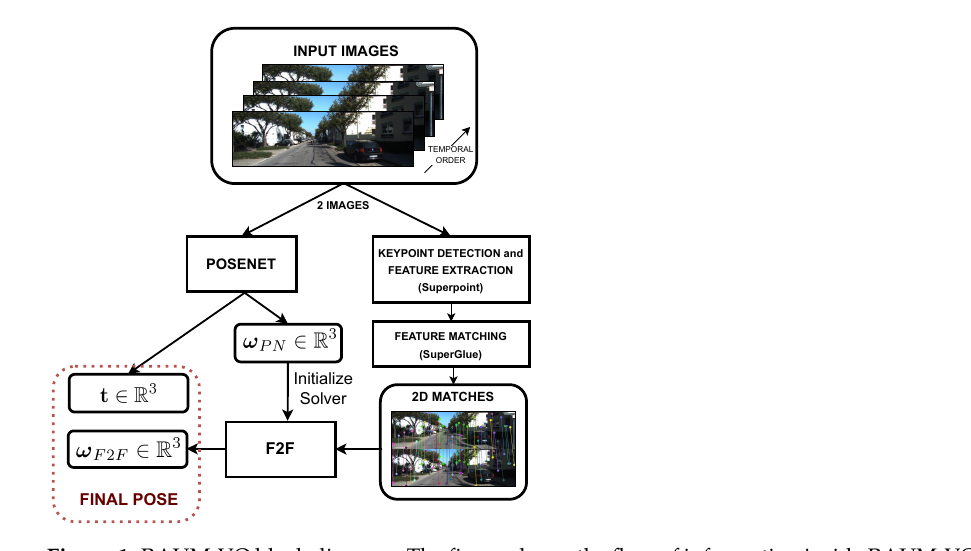
Figure 1. RAUM-VO block diagram. The figure shows the flow of information inside RAUM-VO from the input image sequence to the final estimated pose between each pair of consecutive image